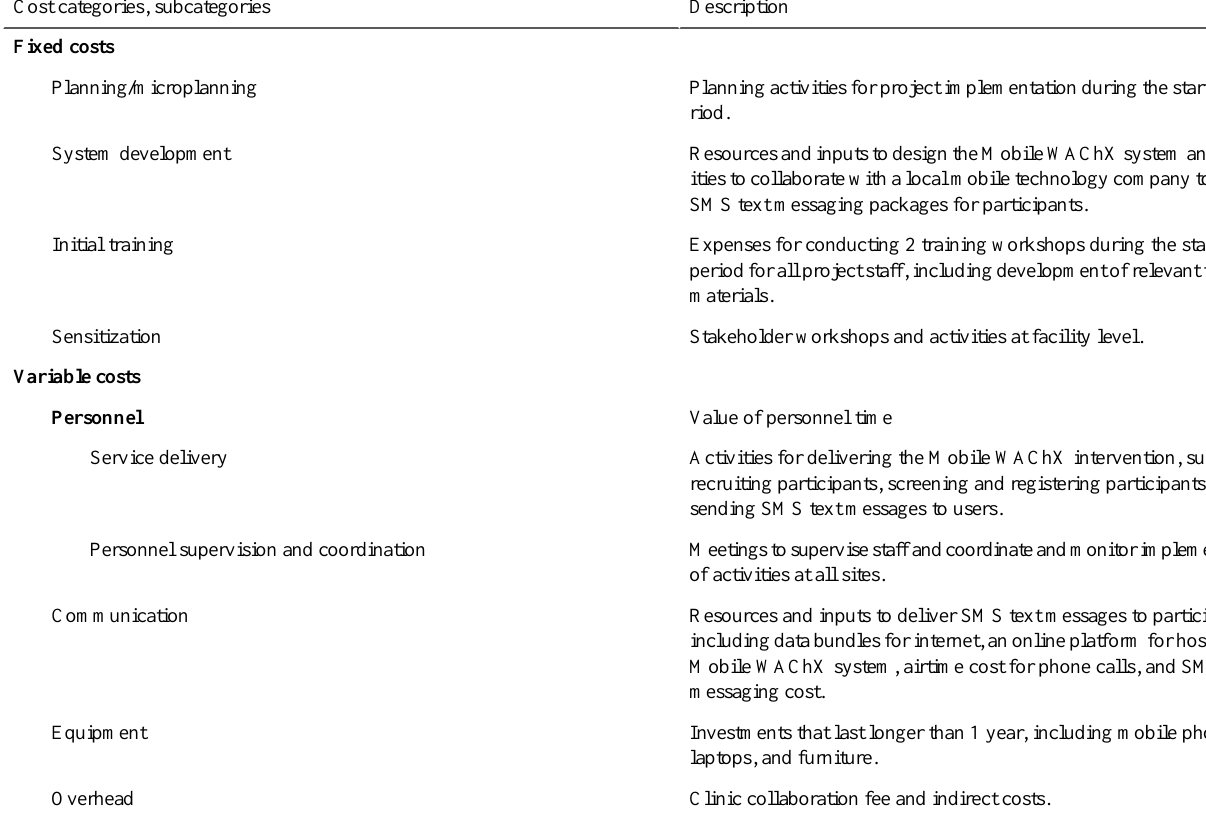
Table 1. Activity and input cost categories and description. DescriptionCost categories,